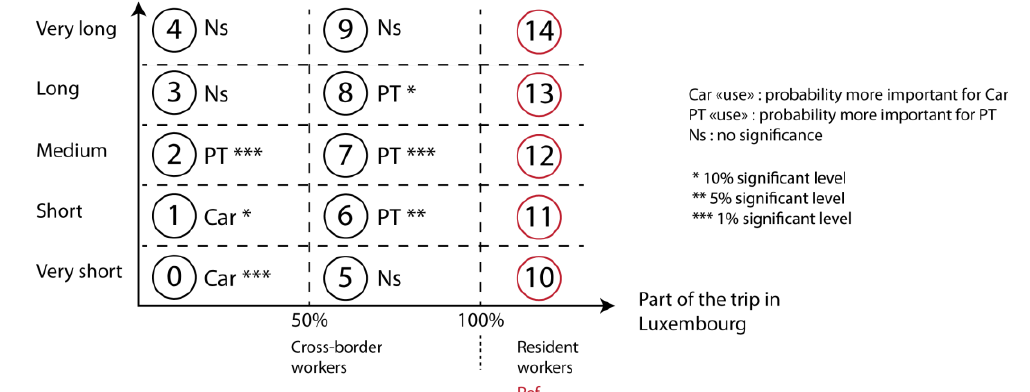
Figure 4. Model 2b: Network efficiency of the border effect